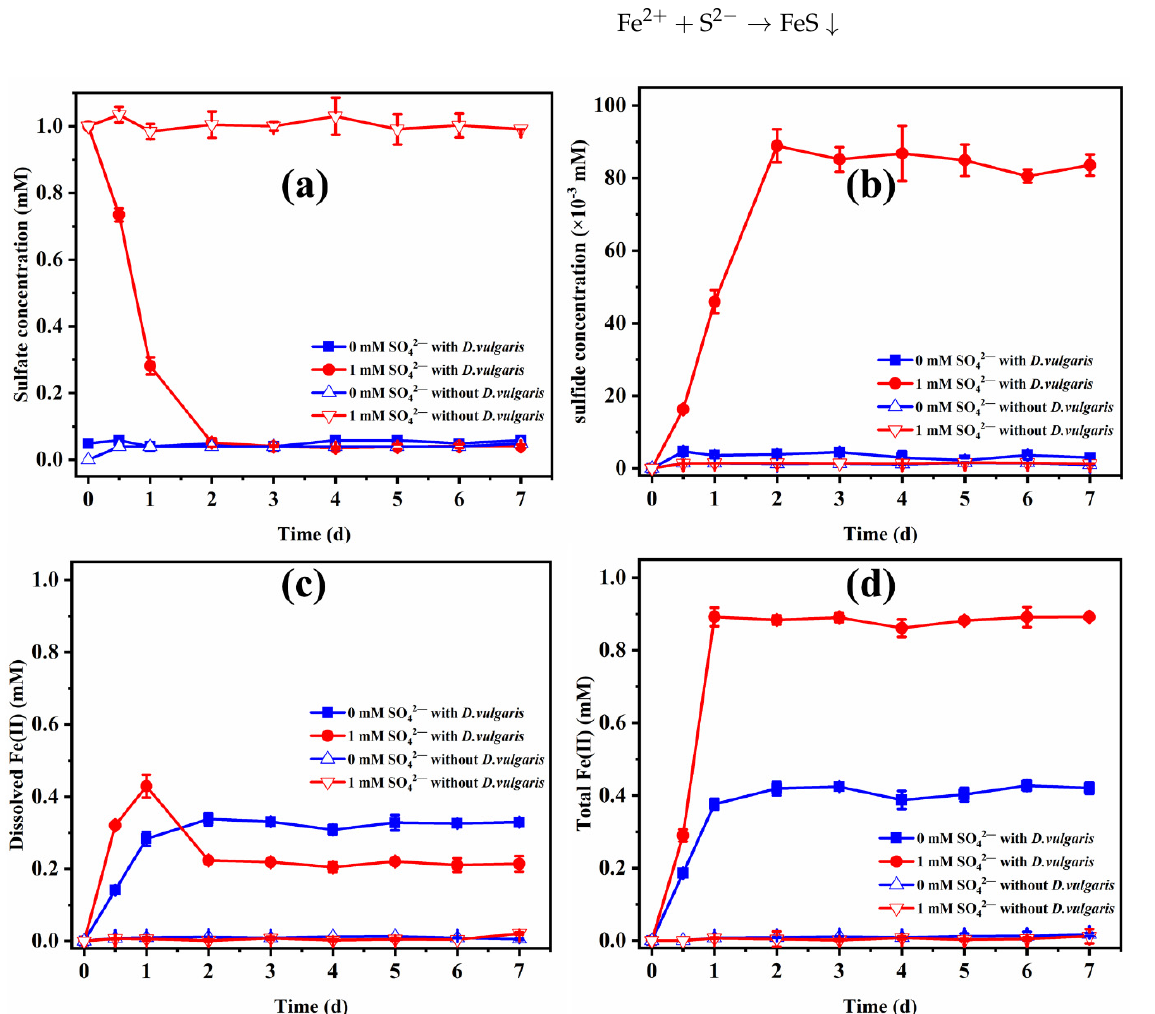
Figure 2. The changes of sulfate ( a ), sulfide ( b ), dissolved Fe (II) ( c ), and total Fe (II) ( d ) concentrations during Fe(III) reduction experiment. Error bars indicate standard deviation of triplicates.